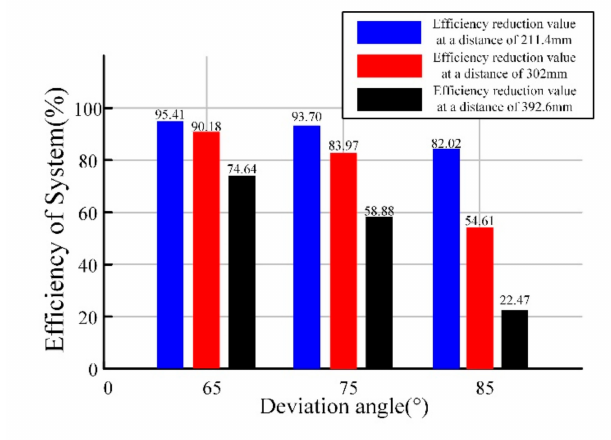
Figure 9. Degree of decrease in system e ffi ciency.